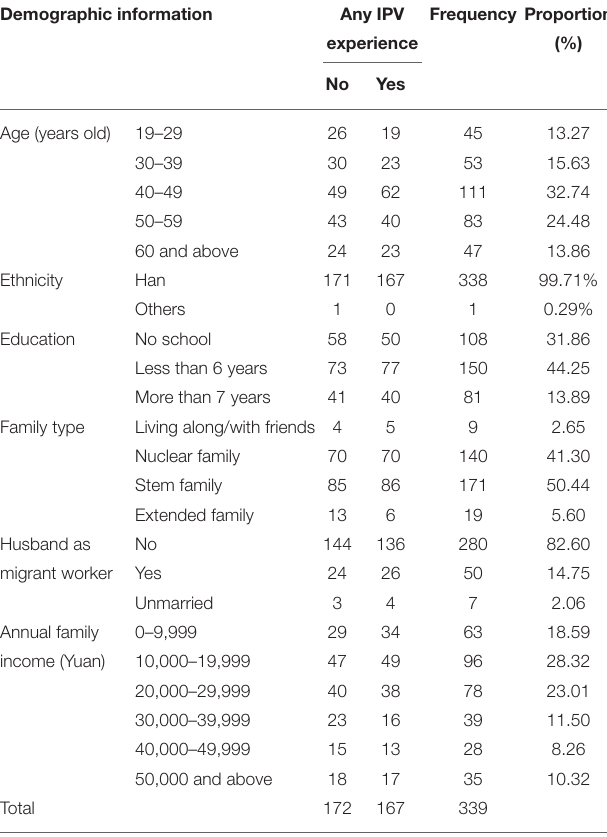
TABLE 2 | The causes of IPV in the vignette explained by participants ( N = 339). Causes of IPV